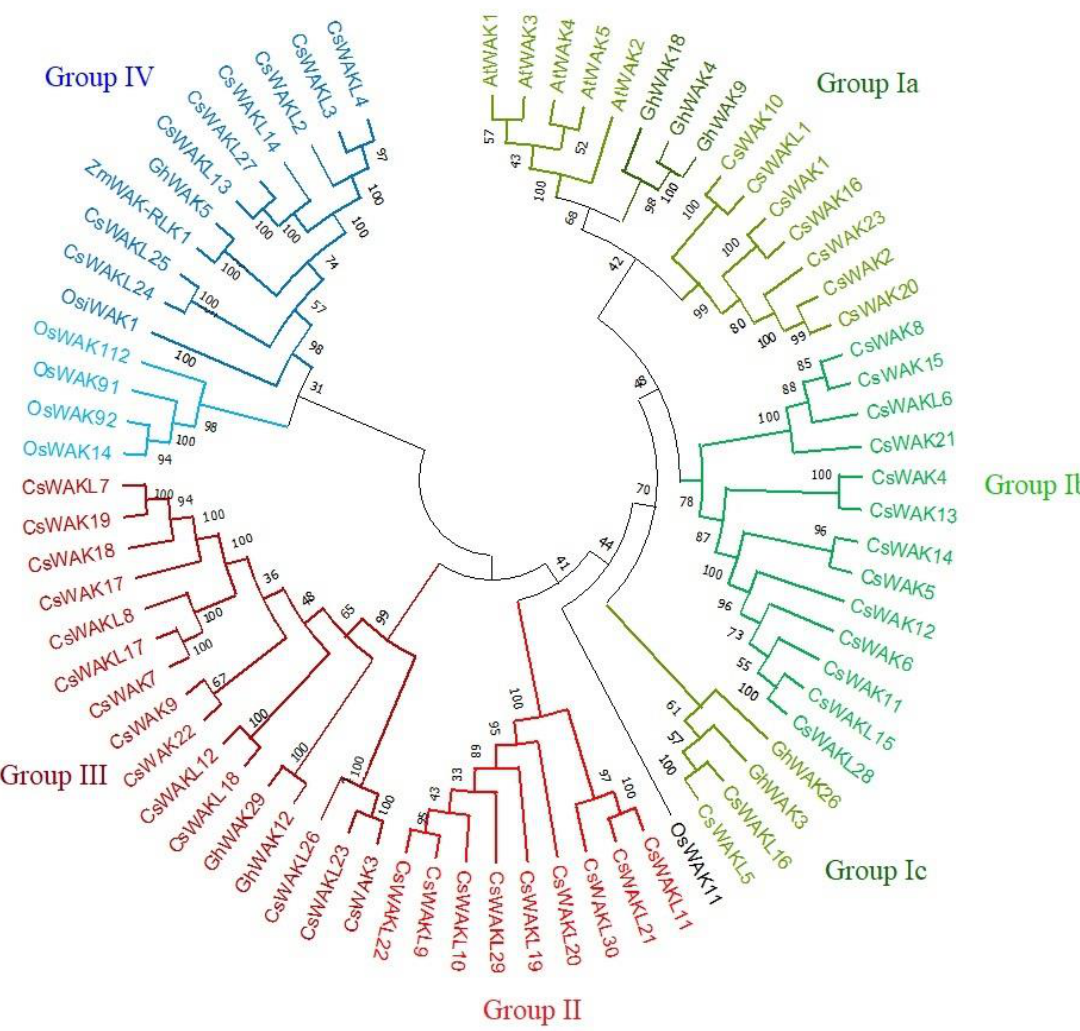
Figure 2. The neighbour-joining phylogenetic tree of WAK/WAKL proteins of Cannabis sativa , Arabidopsis thaliana, Gosyphium hirsutum, Oryza sativa, and Zea mays was conducted using MEGA 11 with a bootstrap of 1000 replicates, based on 95% shared amino acid sites. The tree was divided into four groups: Group I, Group II, Group III, and Group IV containing green, red, maroon, and blue colors, respectively.